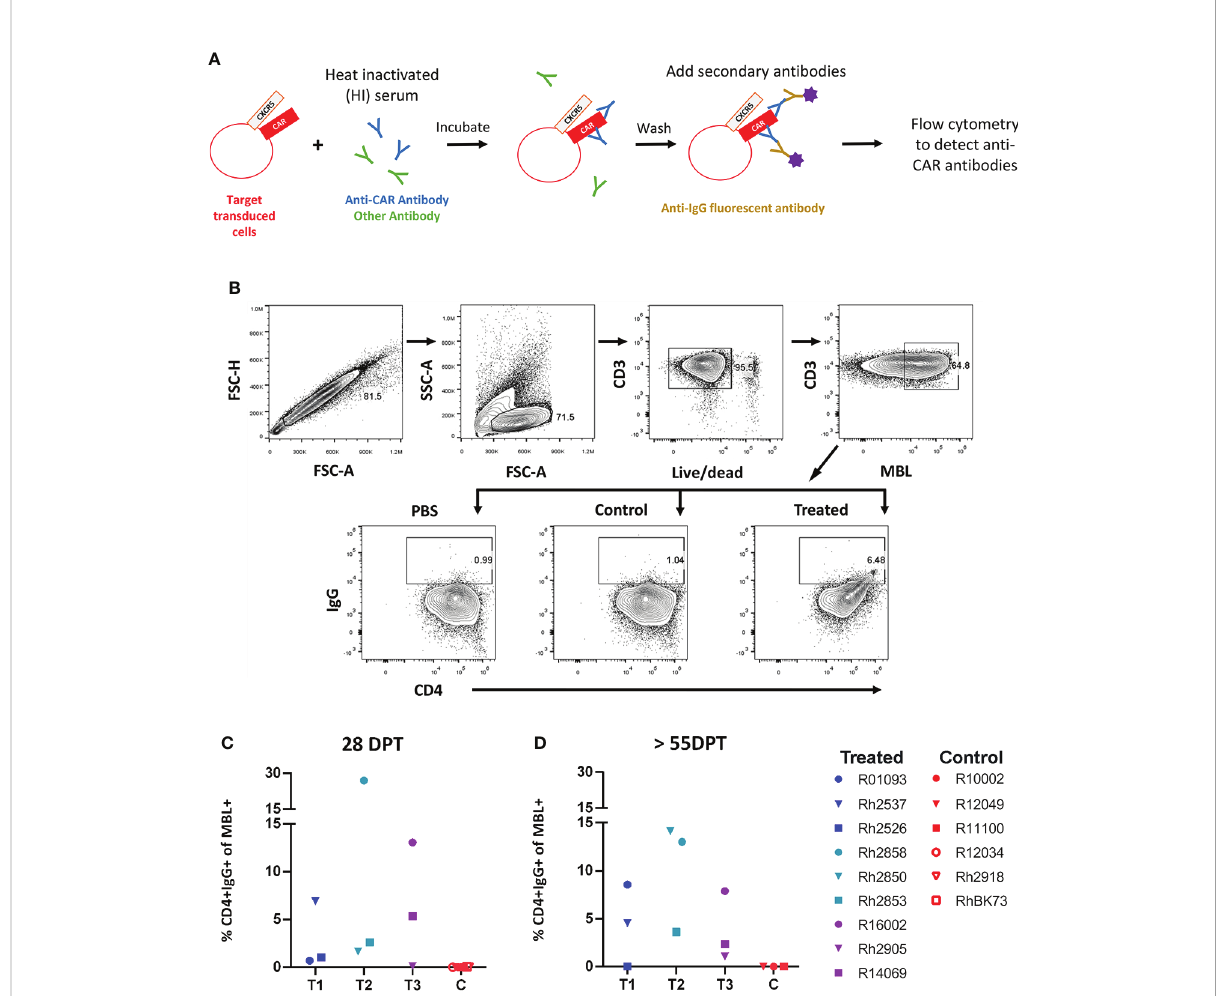
FIGURE 1 Anti-CAR antibodies detected at varying levels in the serum of all animals that received an infusion of CD4-MBL CAR/CXCR5 T cells. (A) Schematic showing antibody binding assay to determine levels of anti-CAR antibodies (percent CD4+IgG+). (B) Gating strategy to determine the amount